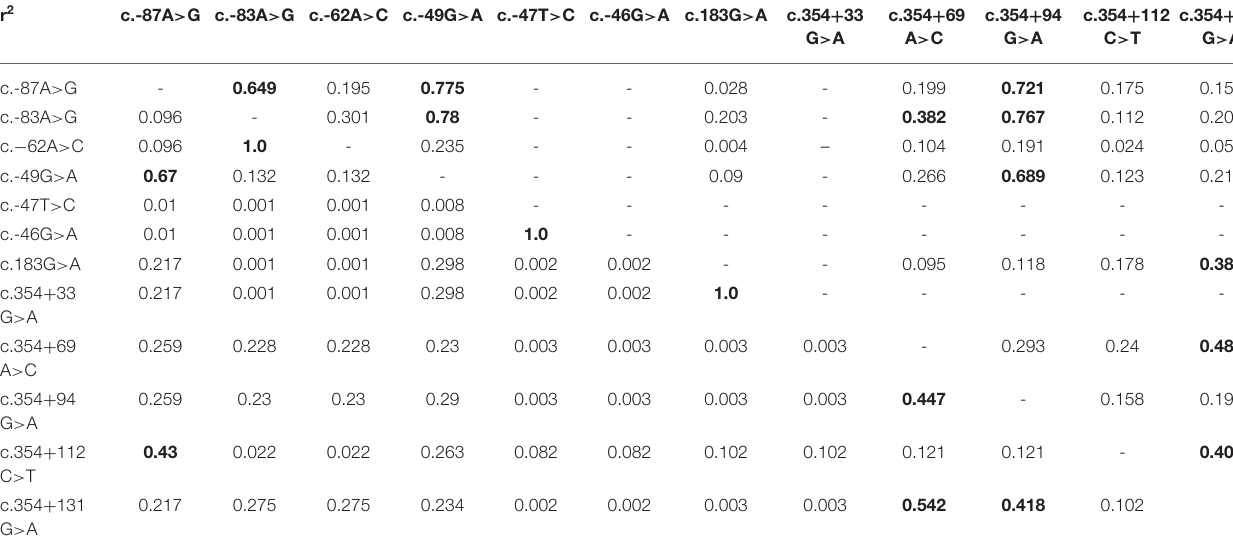
TABLE 2 | Linkage disequilibrium (LD) among genetic polymorphisms of the SPRN gene in chickens. r